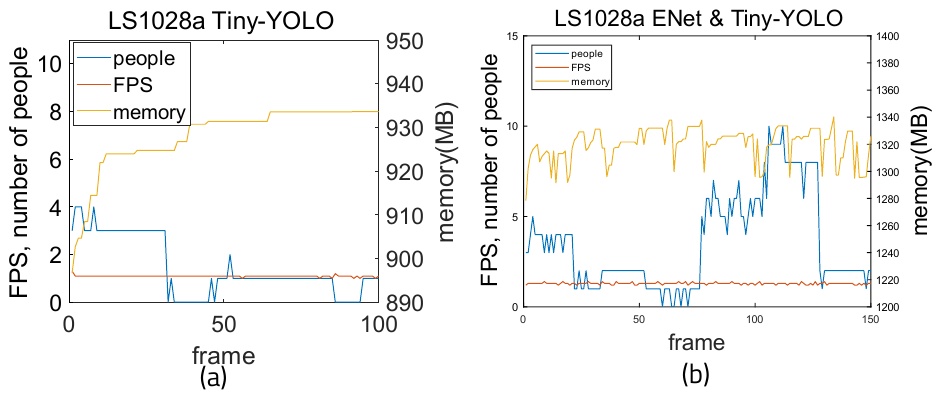
Figure 19. Measurement results for LS1028a board: ( a ) Tiny-YOLO and ( b ) ENet and Tiny-YOLO.